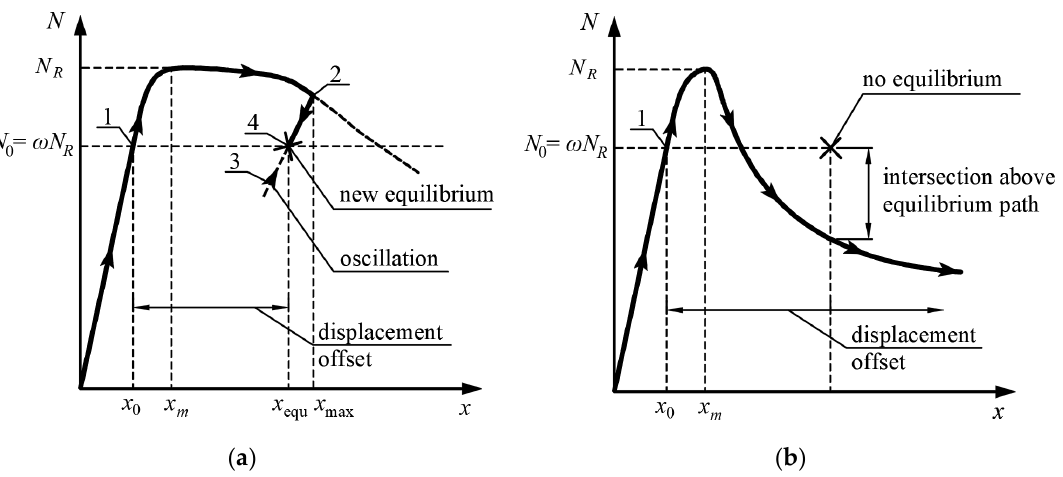
Figure 7. Equilibrium path for a column that exhibits: ( a ) sufficient and ( b ) insufficient ductility. 1—displacement and force in the column just before the excitation; 2—maximum instantaneous displacement; 3—oscillation around the equilibrium position; 4—permanent final displacement.